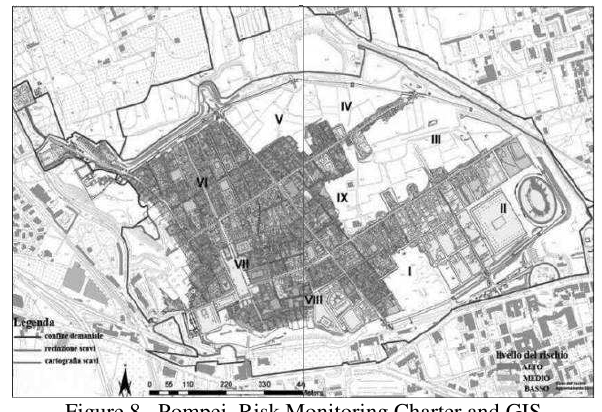
Figure 8. Pompei, Risk Monitoring Charter and GIS (Cecchi, 2011)